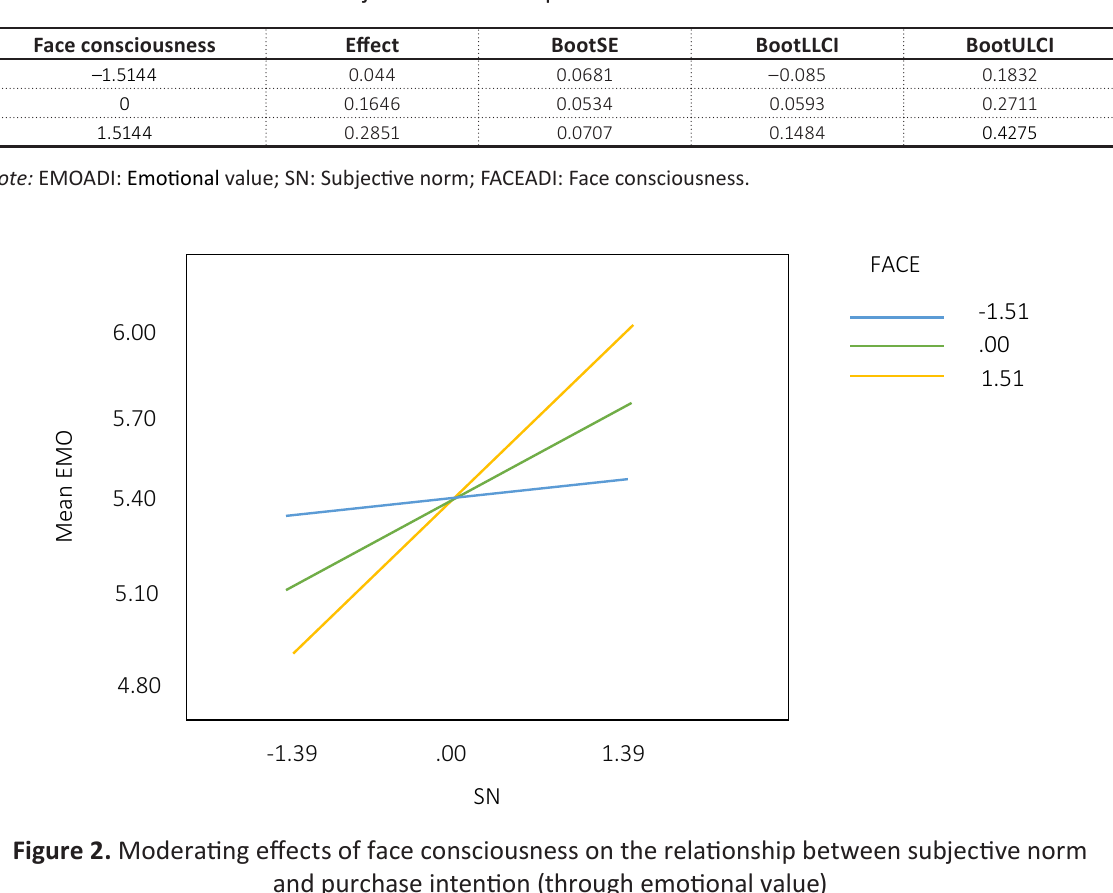
Table 5. Conditional effects of subjective norm on purchase intention